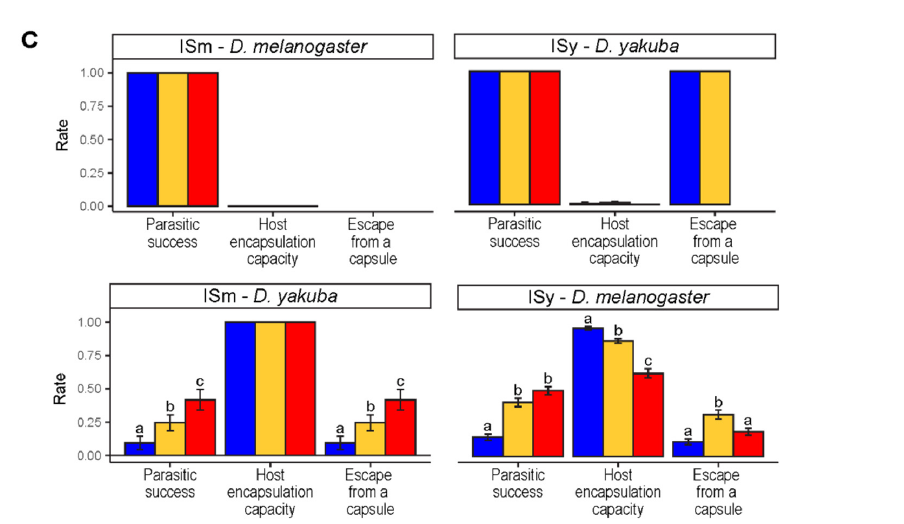
Figure 2. Impact of temperature during parasitism on the outcome of host–parasitoid interaction. ( A ) Possible outcomes in parasitized Drosophila larvae 48–72 h after parasitism and details of analyzed parameters: parasitic success, host encapsulation capacity, parasitoid ability to inhibit encapsulation and parasitoid capacity to escape from a capsule. ( B ) Parasitism rates for the four host–parasitoid interactions as a function of temperature. ( C ) Rate of (i) parasitic success, (ii) host encapsulation capacity or (iii) parasitoid capacity to escape from a capsule, depending on the temperature. Within each host–parasitoid interaction, different letters indicate a significant difference between temperatures for a given parameter. Bars indicate standard errors (see Supplementary Tables S1 and S2 for sample sizes and statistical outputs).